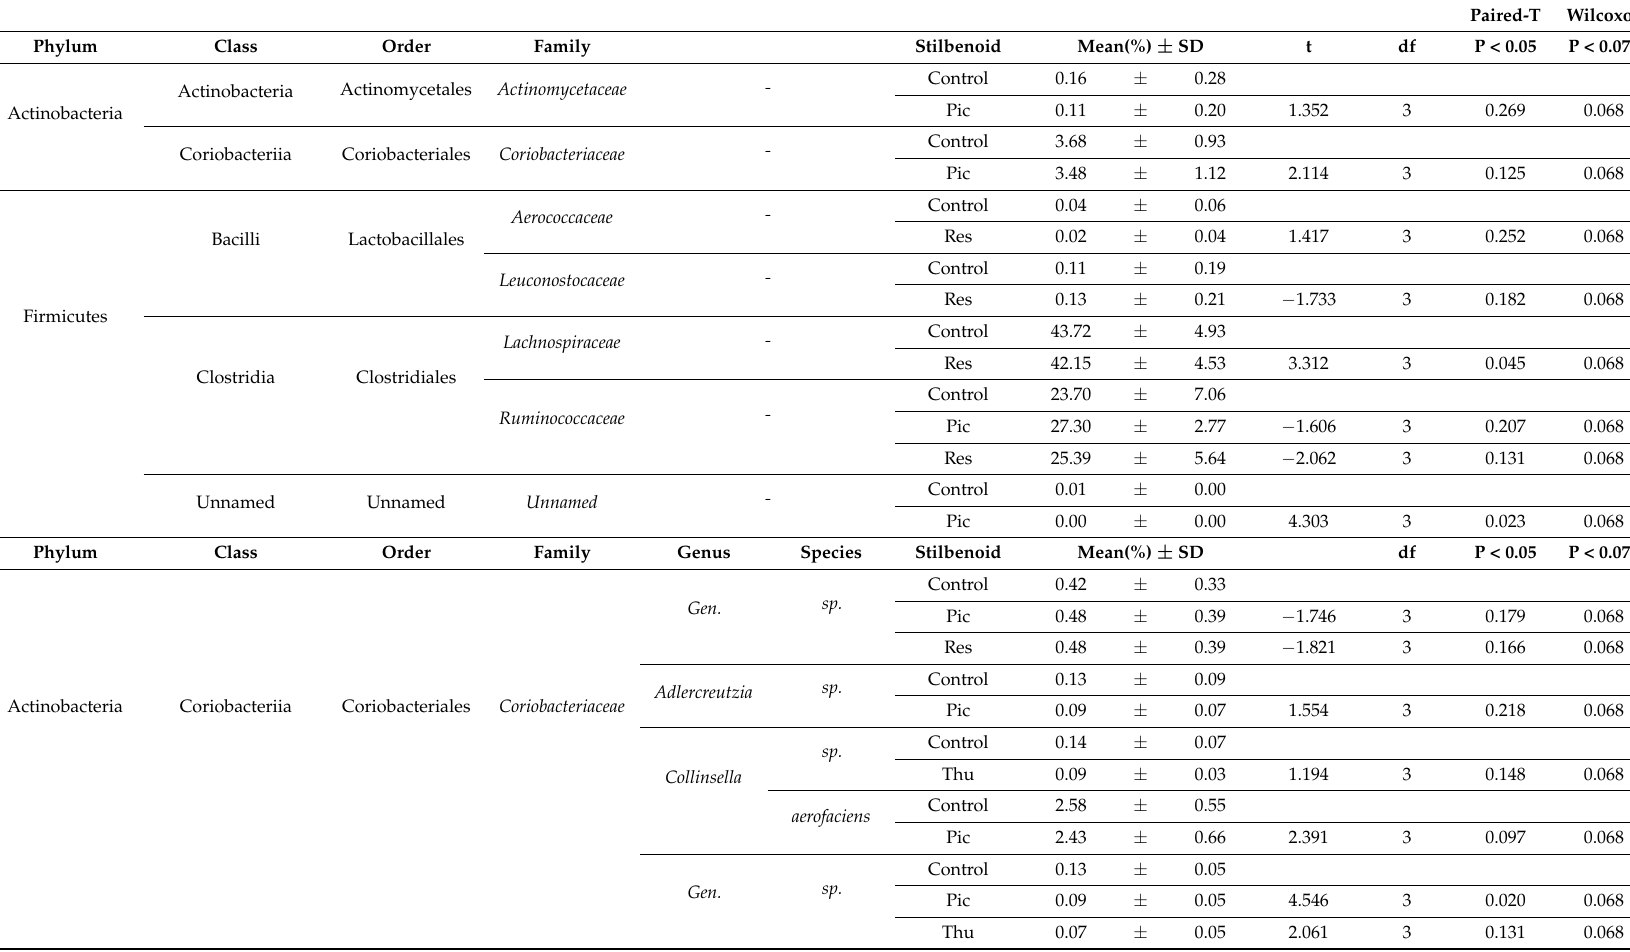
Table A3. Identified taxa based on Comparison 1, which used as a baseline the relative abundance of the 24 h control, and compared that to each of the six stilbenoid fermentations at 24 h. Taxa displayed Paired-T p value <0.05 and/or Wilcoxon Signed Rank p value <0.075. Bolded values are those within these ranges. Gen. = unnamed genus, sp. = unnamed